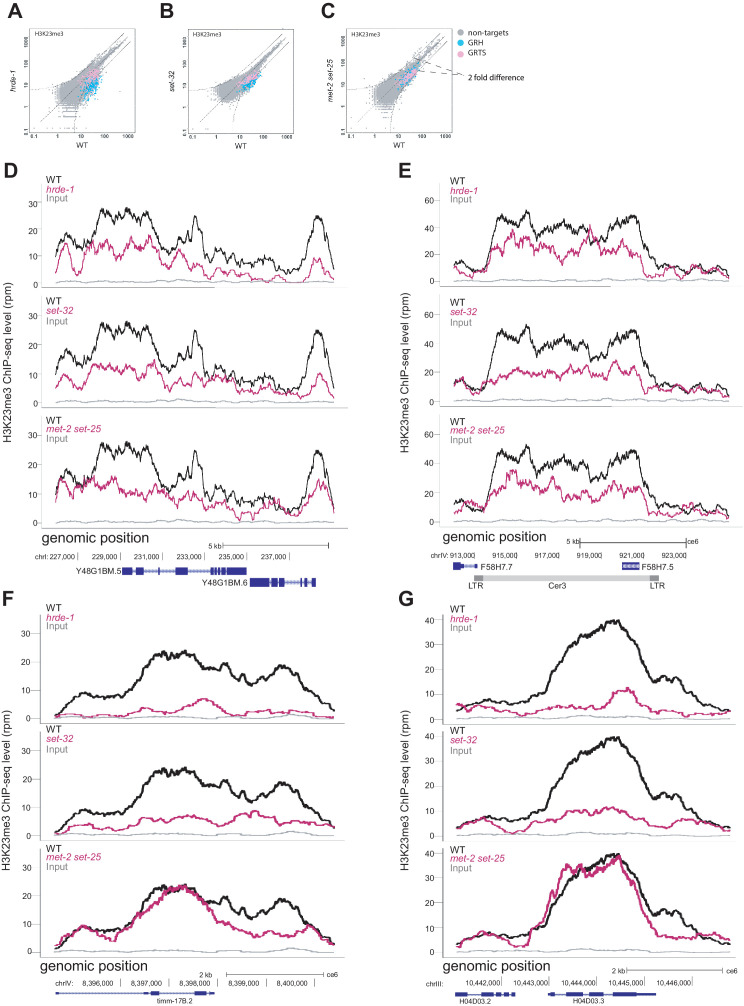
Genetic requirements for H3K23me3 at additional loci.(A–C) Scatter plots of H3K23me3 ChIP whole-genome coverage in which each point represents a 1kb window of the genome with GRH and GRST loci highlighted. Mutant coverage is plotted on the y axis and WT coverage is plotted on the x axis. Curved dashed lines indicated two-fold difference (FDR≤0.05). (D-G) H3K23me3 levels (y axis) are plotted as a function of genomic position along the x axis in three mutant strains. Top panel: hrde-1, middle panel: set-32, bottom panel: met-2 set-25. For each panel WT is plotted in black, mutant is plotted in pink, grey is input in WT. The genomic loci are as follows: (D): Cer12, (E): Cer3, (F) :D2096.1, a top set-32-dependent gene, (G): H04D03.3, a top set-32-dependent gene. All signals normalized to sequencing depth.